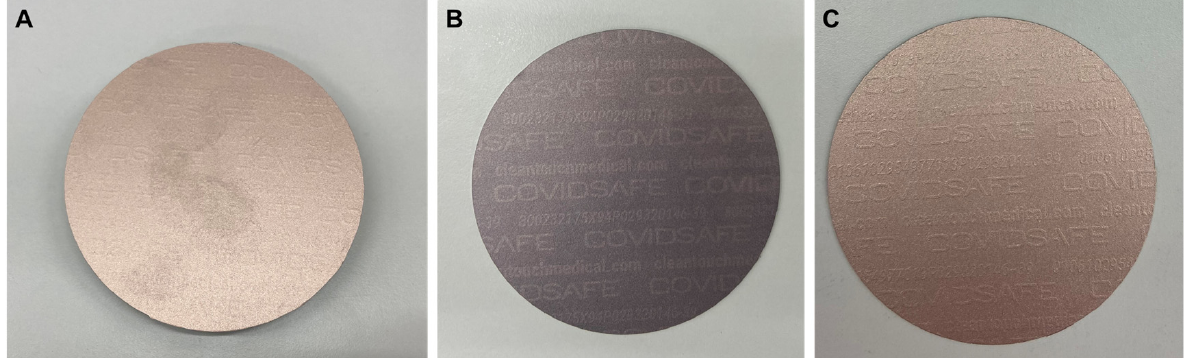
Figure 1. Different surface-plated samples with different colors were delivered to the University of Helsinki for inhibition testing against severe acute respiratory syndrome coronavirus 2 (SARS-CoV-2) (samples A and B) and murine norovirus (MNV) (sample C): ( A ) and ( C ) are bronze-brown surfaces, and ( B ) is dark brown surface. All surfaces were imprinted with COVID- SAFE labeling, representing surface roughness.